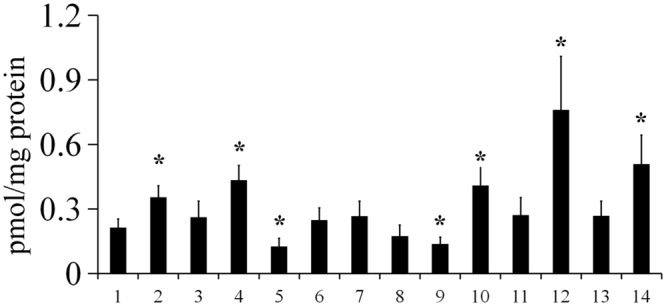
The intracellular c-di-GMP level in Y. pestis in various environmental conditions. c-di-GMP was extracted from Y. pestis grown in LB medium at 26°C (1), 21°C (7), or 37°C (8), or in LB medium supplemented with CaCl2 (2), MgCl2 (3), CuSO4 (4), FeCl2 (5), NaCl (9), sucrose (10), H2O2 (11), DTT (12), DIP (13), or SDS (14), or at pH 5 (6) at 26°C, and measured as described in the Experimental Procedures. ∗P < 0.05. The mean and standard deviation of three independent experiments are indicated.